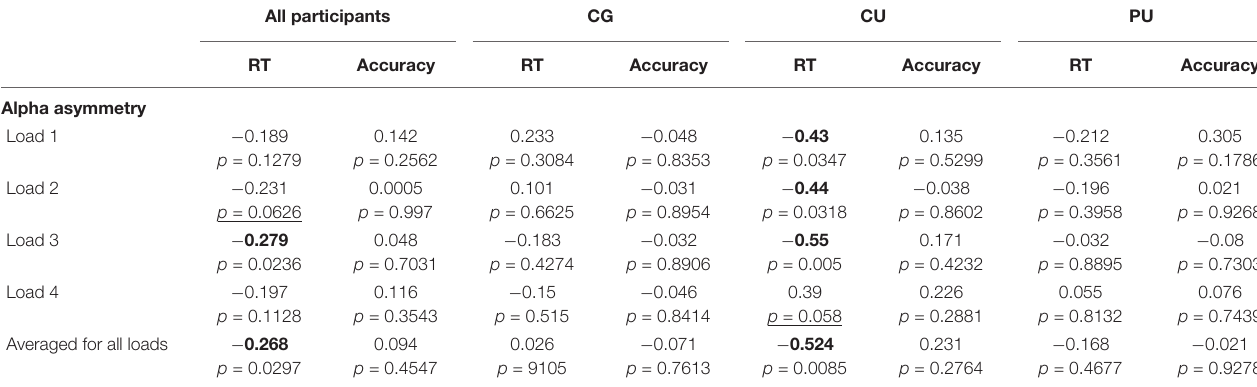
TABLE 4 | Pearson coefficients for correlations (with p value reported) between RT and accuracy and alpha posterior asymmetry (P4/3, P6/5, PO4/3, and PO8/7) during maintenance, at all WM loads and averaged across all memory loads for all participants and each group separately: control group (CG), cannabis users (CU), polydrug users